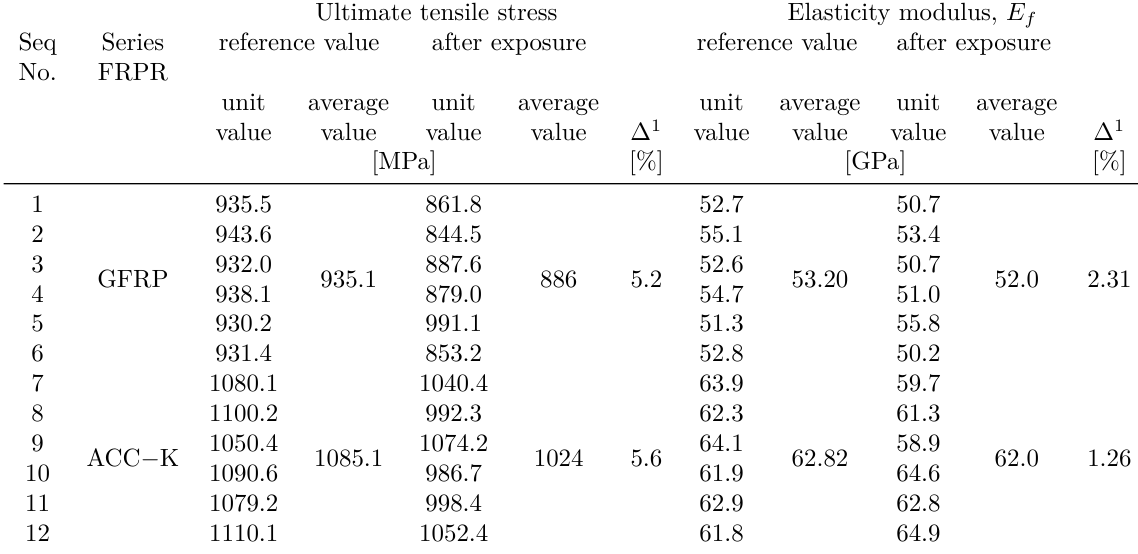
Table 3. FRPR strength under axial tension